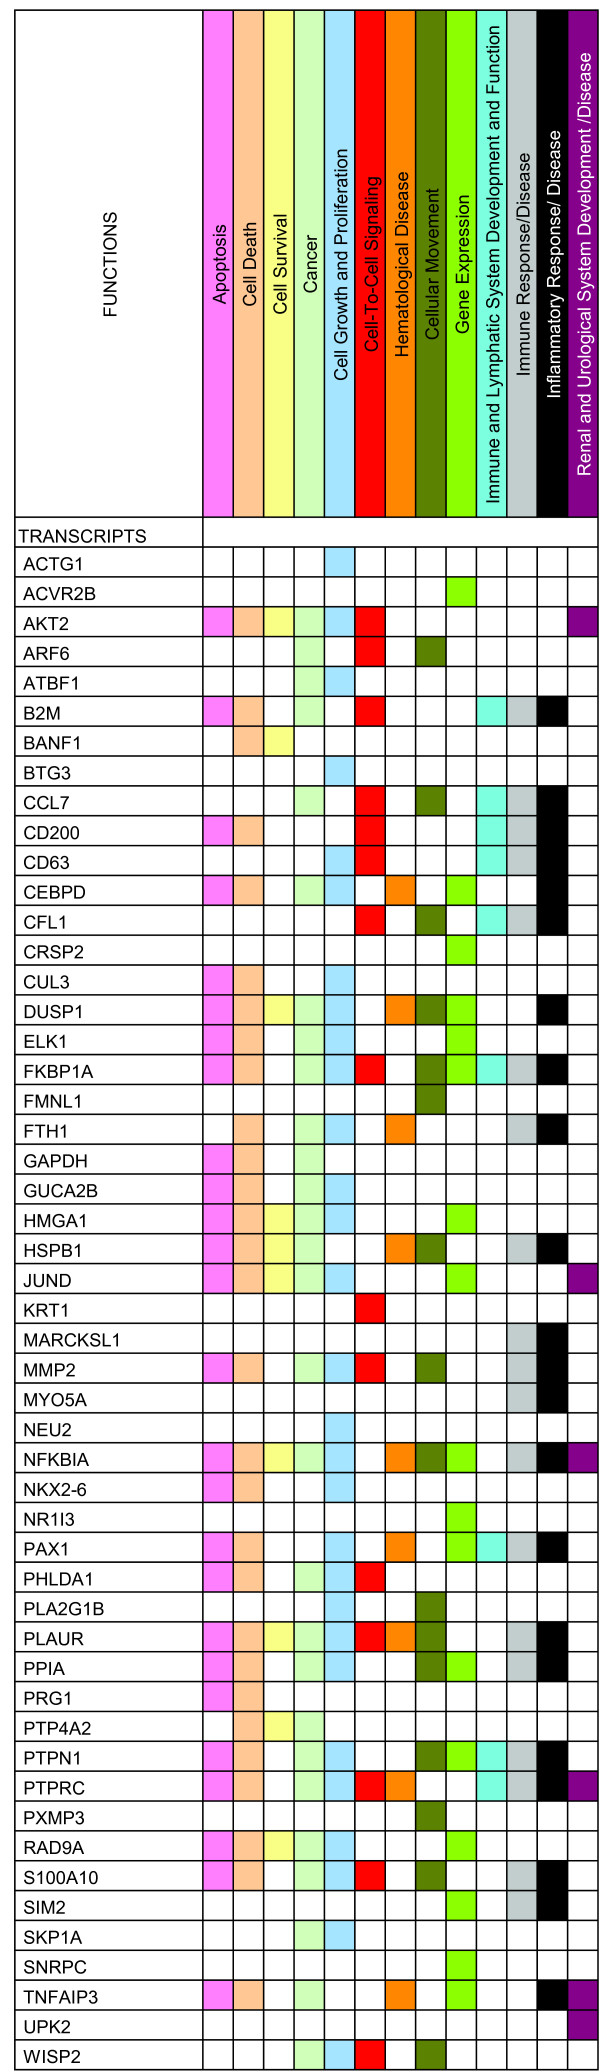
Functions and disease shared by PAR1-depend transcripts.